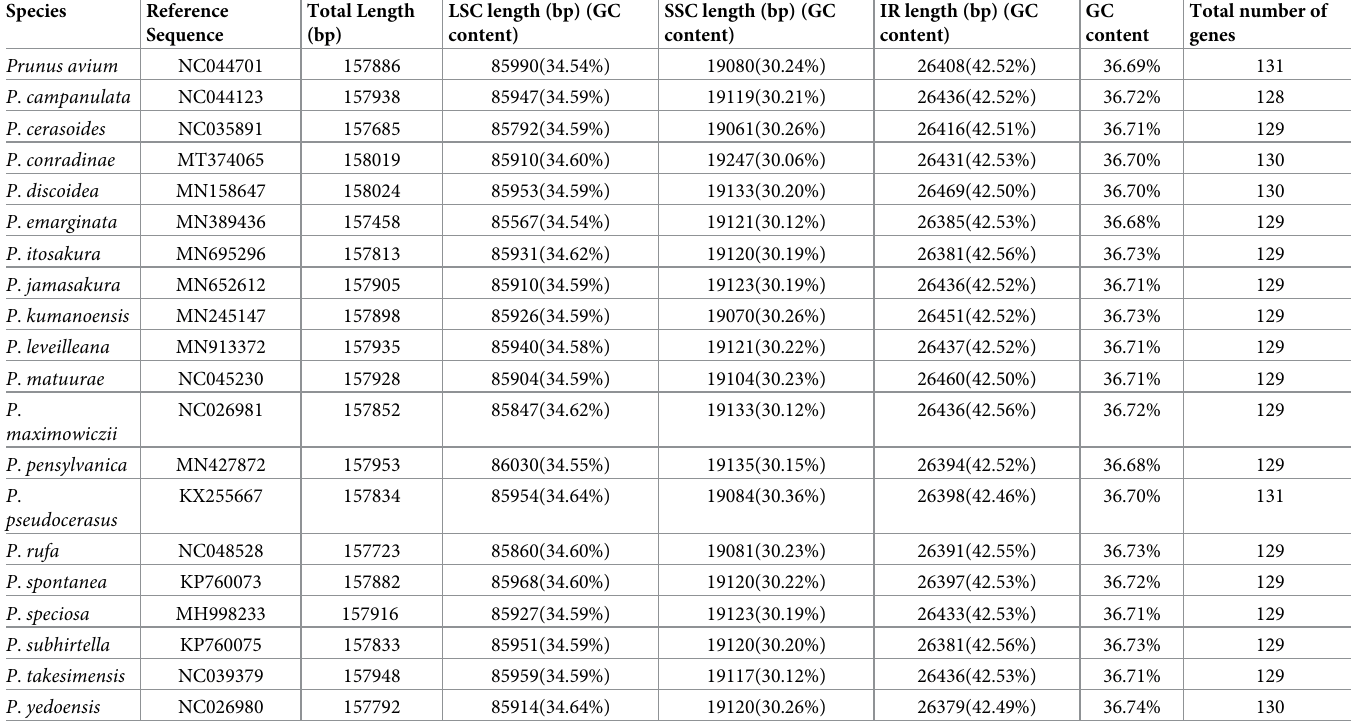
Table 1. Sample information and summary of plastome characteristics for the 20 subg. Cerasus species studied. Species Reference